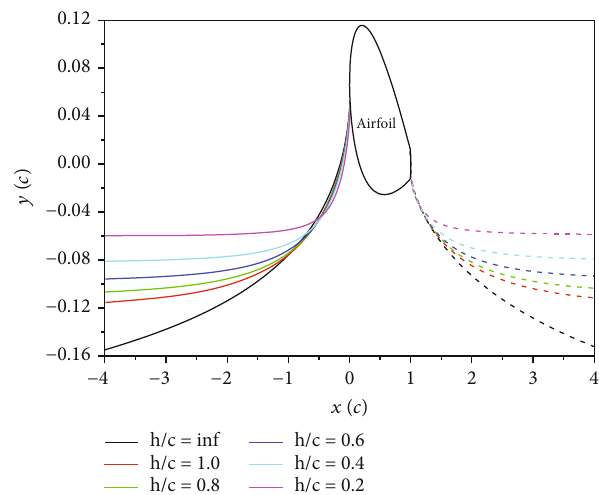
Figure 27: Leading edge stagnation streamlines and the streamlines beginning from the jet separation point on the Coanda surface for C = 0 : 013 at α = 4 ° .. μ